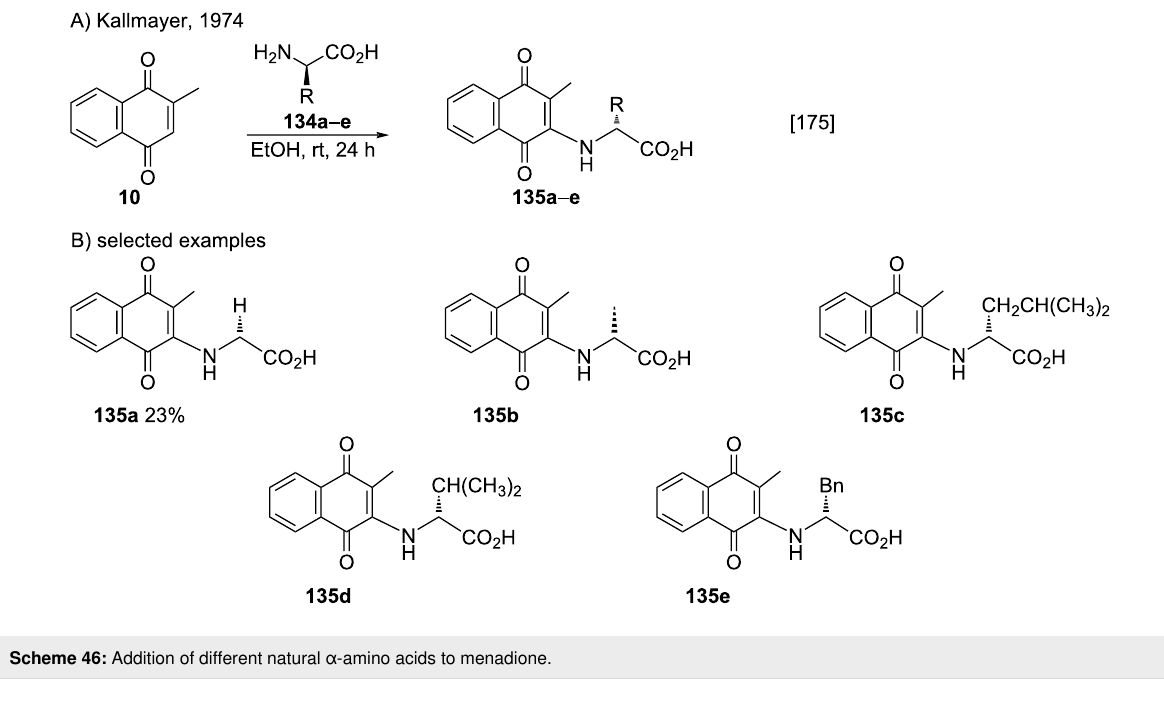
Table 6: Reaction conditions for the addition of amines to menadione by Mital and co-workers.